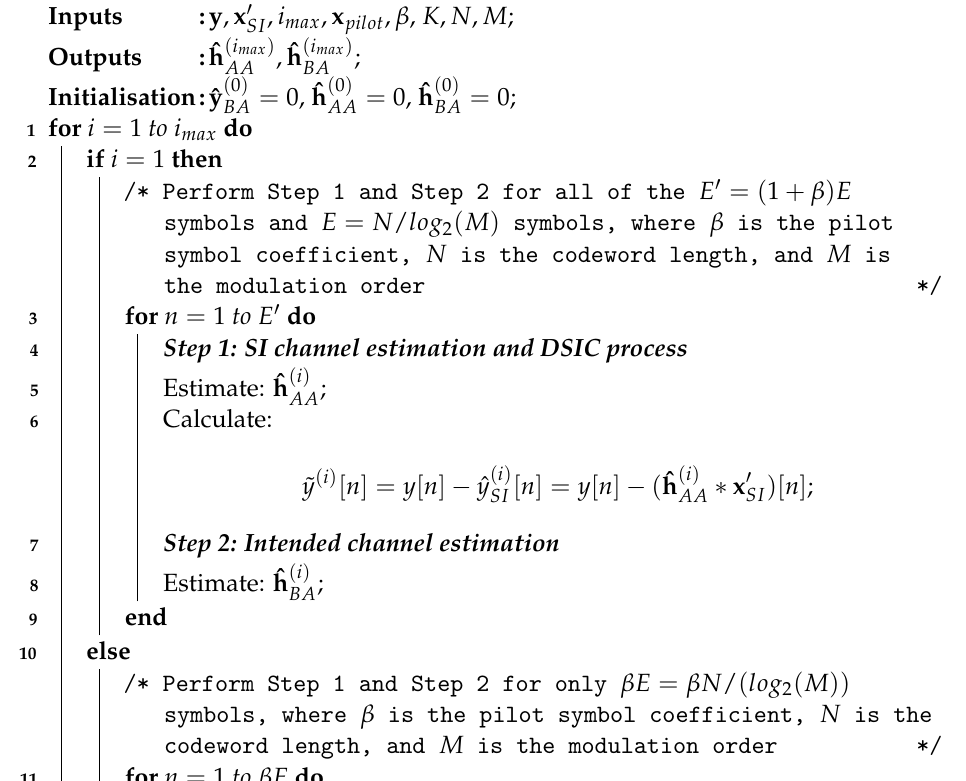
Algorithm 1: Iterative part of the proposed joint iterative semi-blind